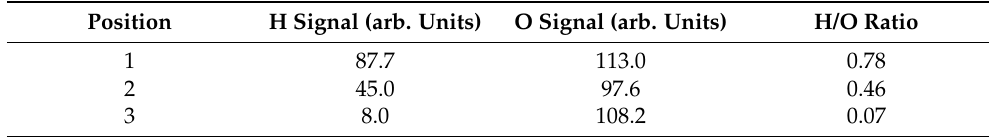
Table 4. H and O signals and their ratio in the normalized LIBS spectra from the three positions on the ice/regolith sample. Position H Signal (arb. Units) O Signal (arb. Units) H/O Ratio 1